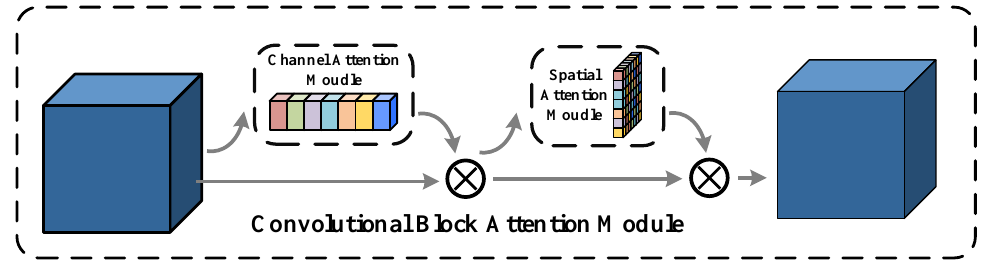
Figure 6. Architecture of